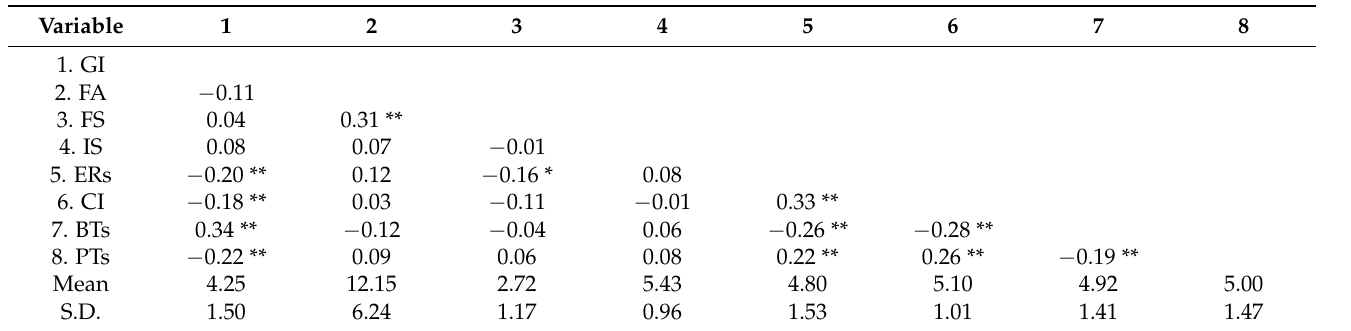
Table 2. Correlations.